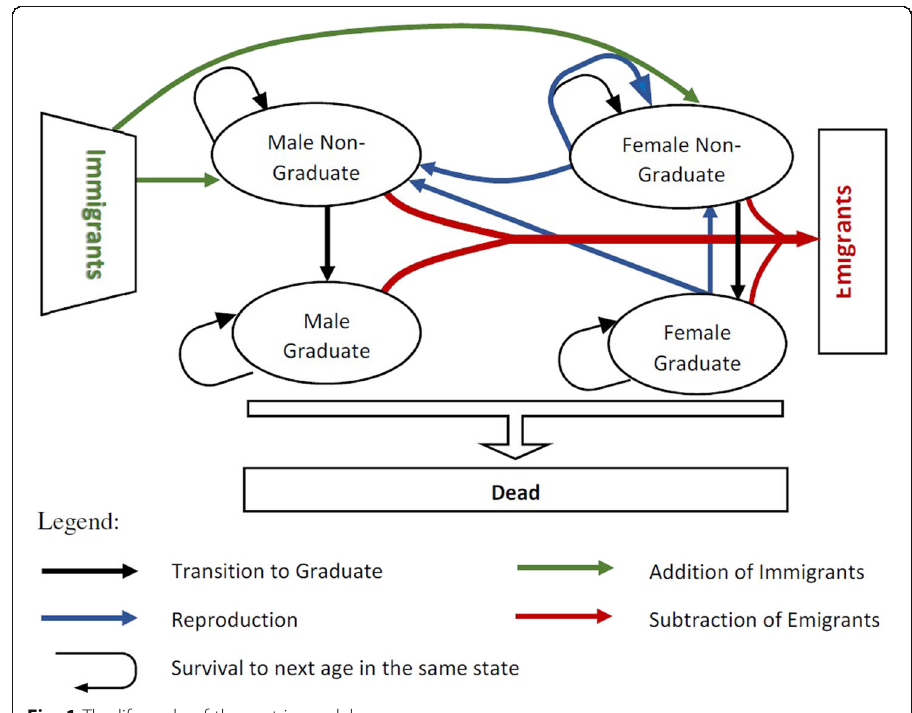
Fig. 1 The life cycle of the matrix